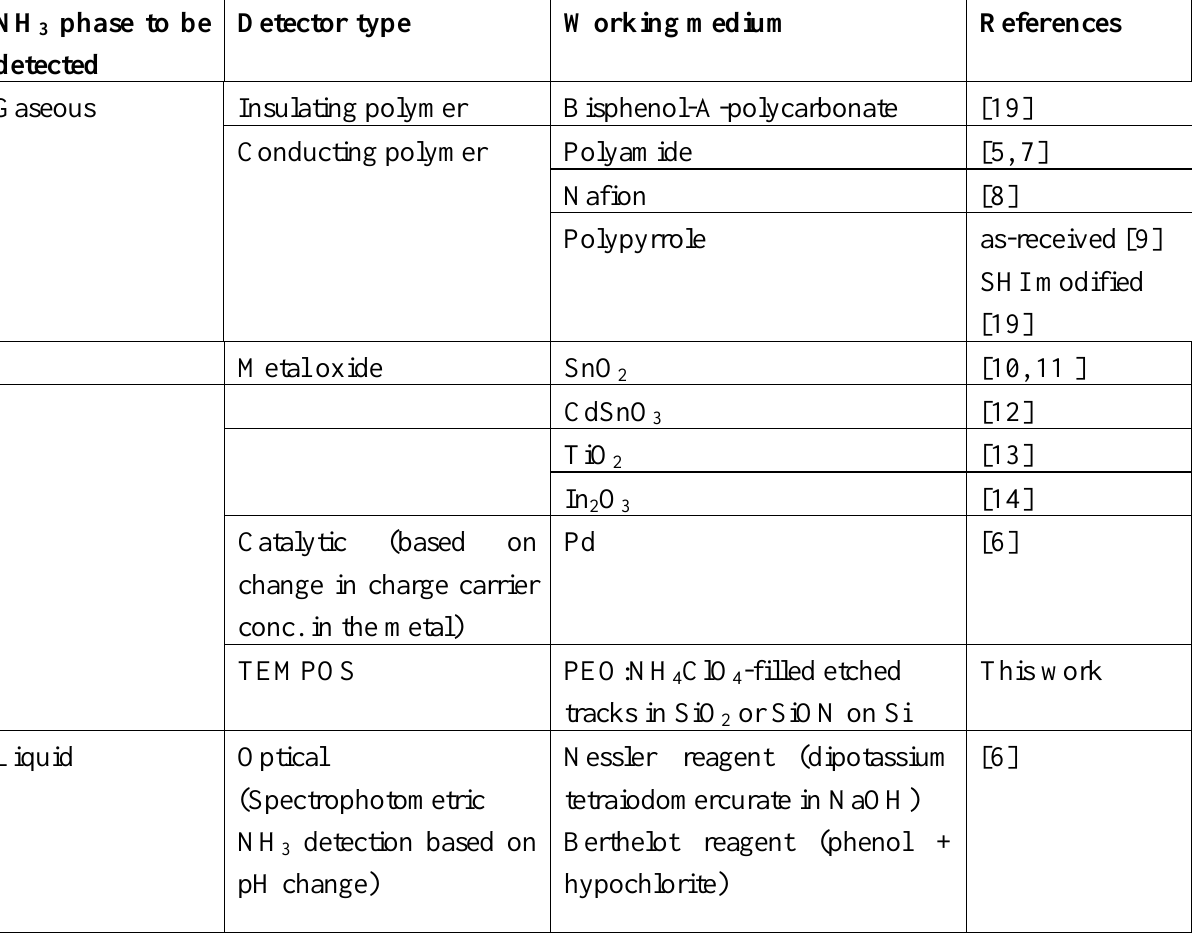
Table 1. Comparison of ammonia